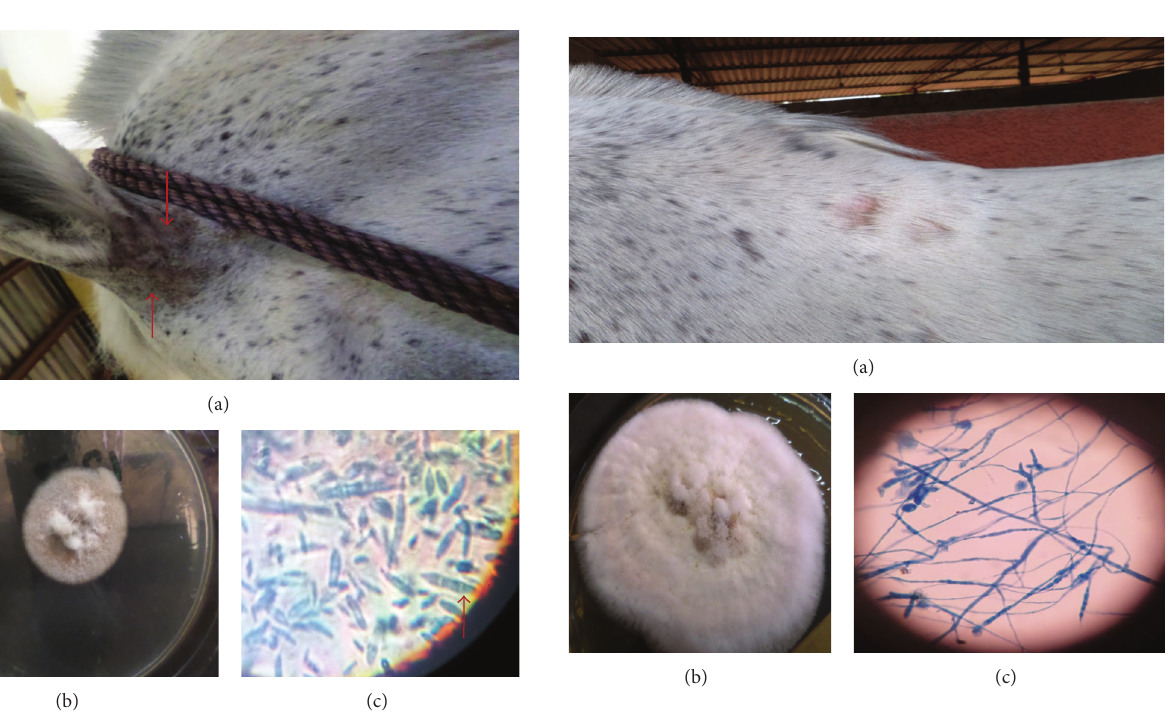
Figure 10: Multiple areas of alopecia on the back of a horse caused by M. canis (a), colony of M. canis (17 days) (b), and microscopy of M. canis showing curved spindle shaped macroconidia with a few distorted, and chlamydospores (c) (LCB ×